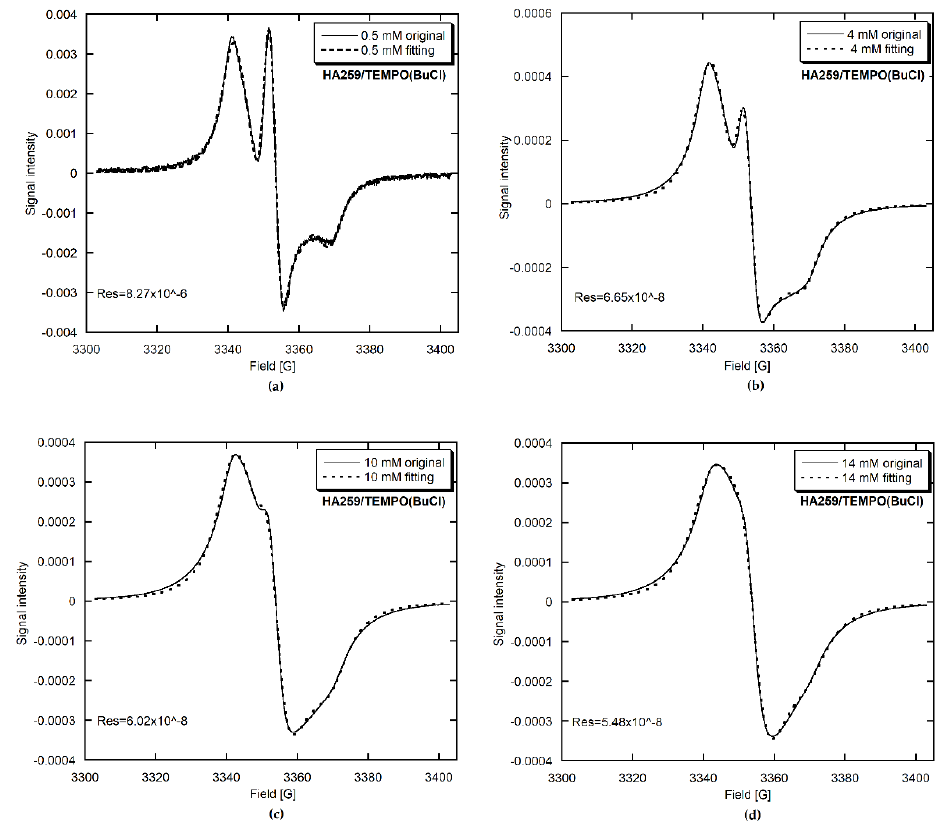
Figure 4. The original and simulated EPR spectra for the HA259/TEMPO(BuCl) composites prepared using four different initial TEMPO concentrations in BuCl: ( a ) 0.5 mM; ( b ) 4 mM; ( c ) 10 mM; ( d ) 14 mM.